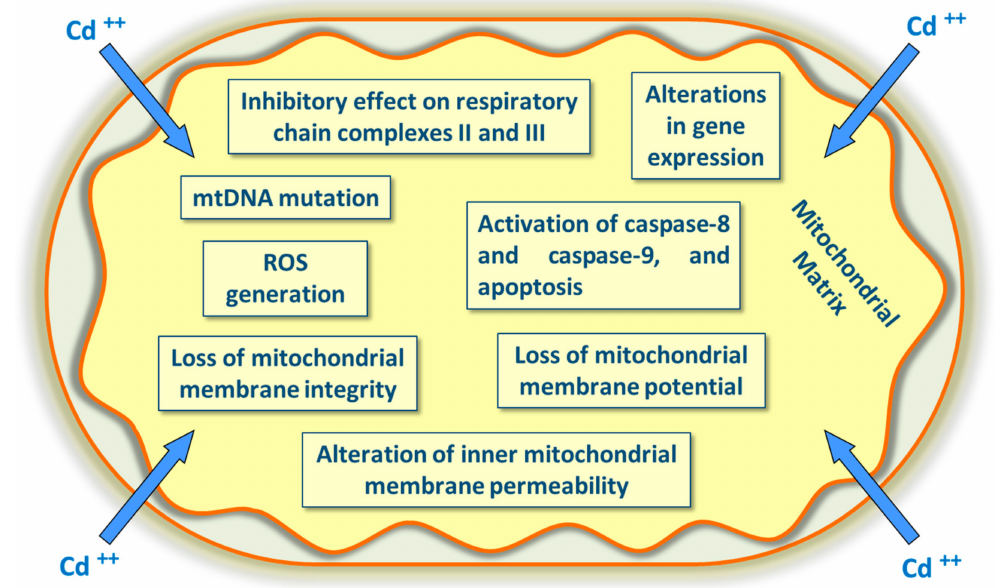
Figure 2. The main target in cadmium intoxication. Cadmium acts on mitochondria by inducing oxidative stress and generating reactive oxygen species (ROS), activating apoptosis, mutating mtDNA, altering gene expression, inhibiting respiratory chain complexes, reducing ATP synthesis, and altering the inner mitochondrial